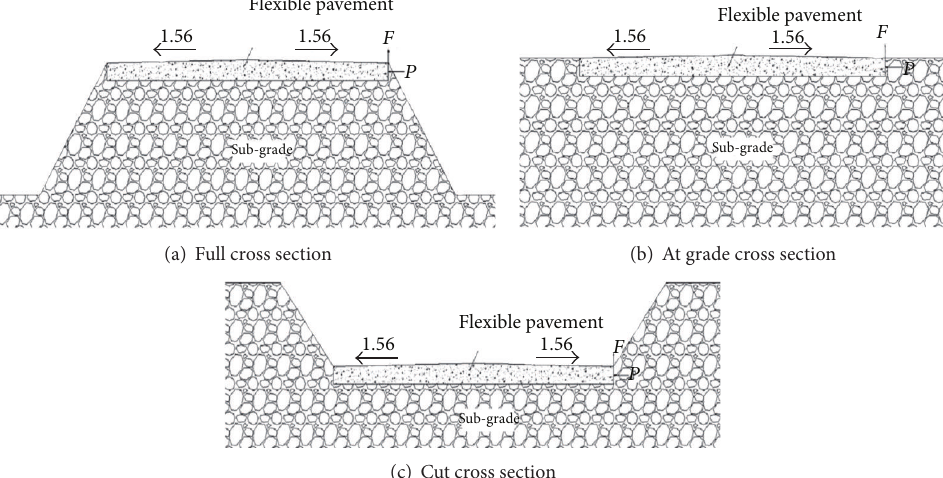
Figure 2: Flexible pavement typical cross section geometries [7].